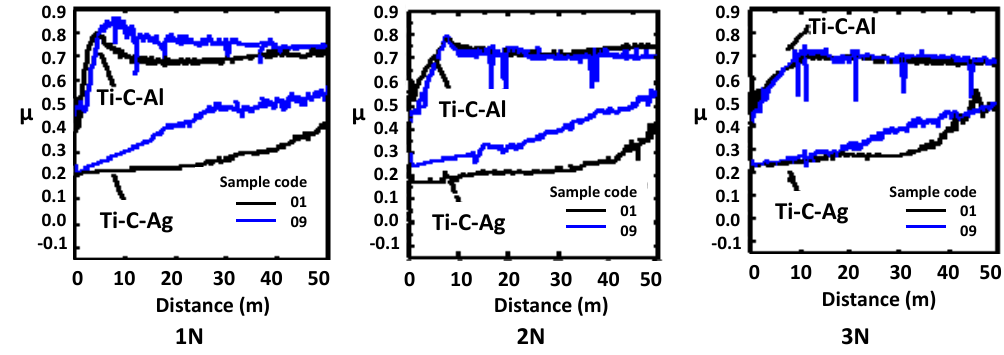
Figure 2. Friction coefficient for Ti-C-Al and Ti-C-Ag thin films deposited on OLC 45 (high-quality carbon steel with 0.45% C) substrate.